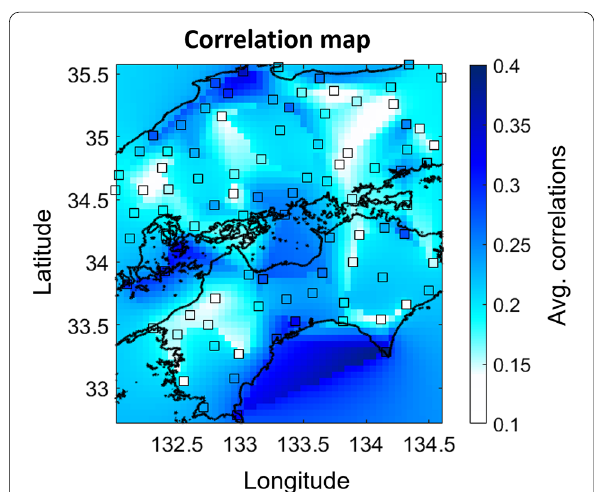
Fig. 8 Correlation map constructed by interpolating and extrapolating the average correlations shown in Fig.